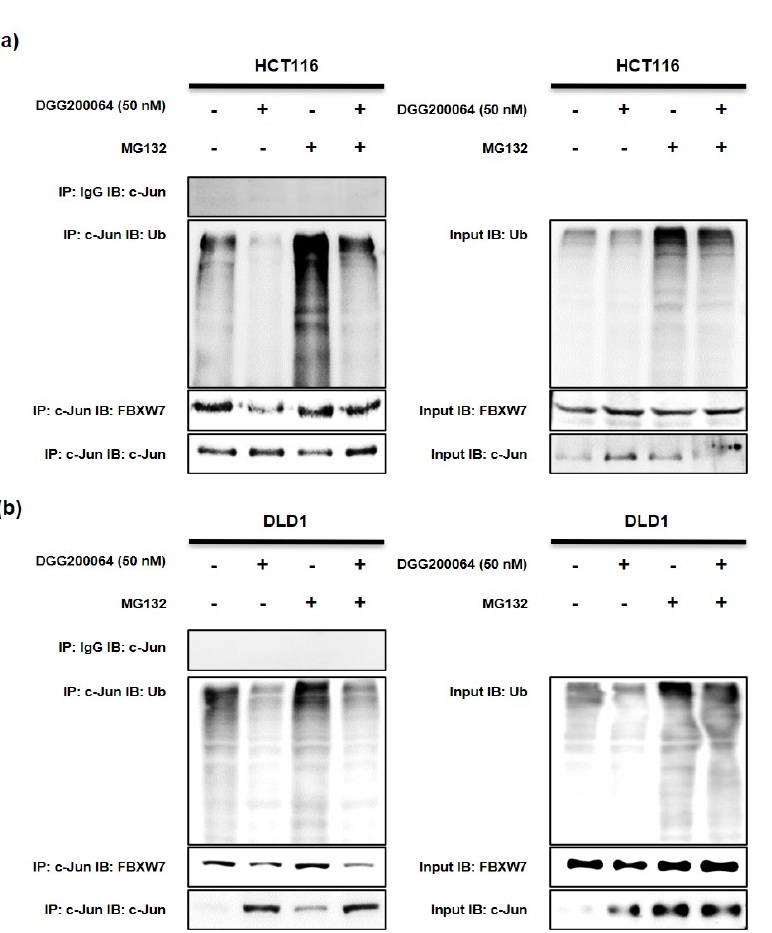
Figure 4. Inhibition of the c-Jun ubiquitination through interruption of FBXW7/c-Jun interaction in ( a ) HCT116 and ( b ) DLD1 cells. Cells were treated with DGG200064 (50 nM) for 18 h; then incubated with or without MG132 (10 µ M) for 6 h. The protein was immunoprecipitated from cell lysates using a c-Jun antibody, followed by immunoblotting of c-Jun, Ubiquitin, and